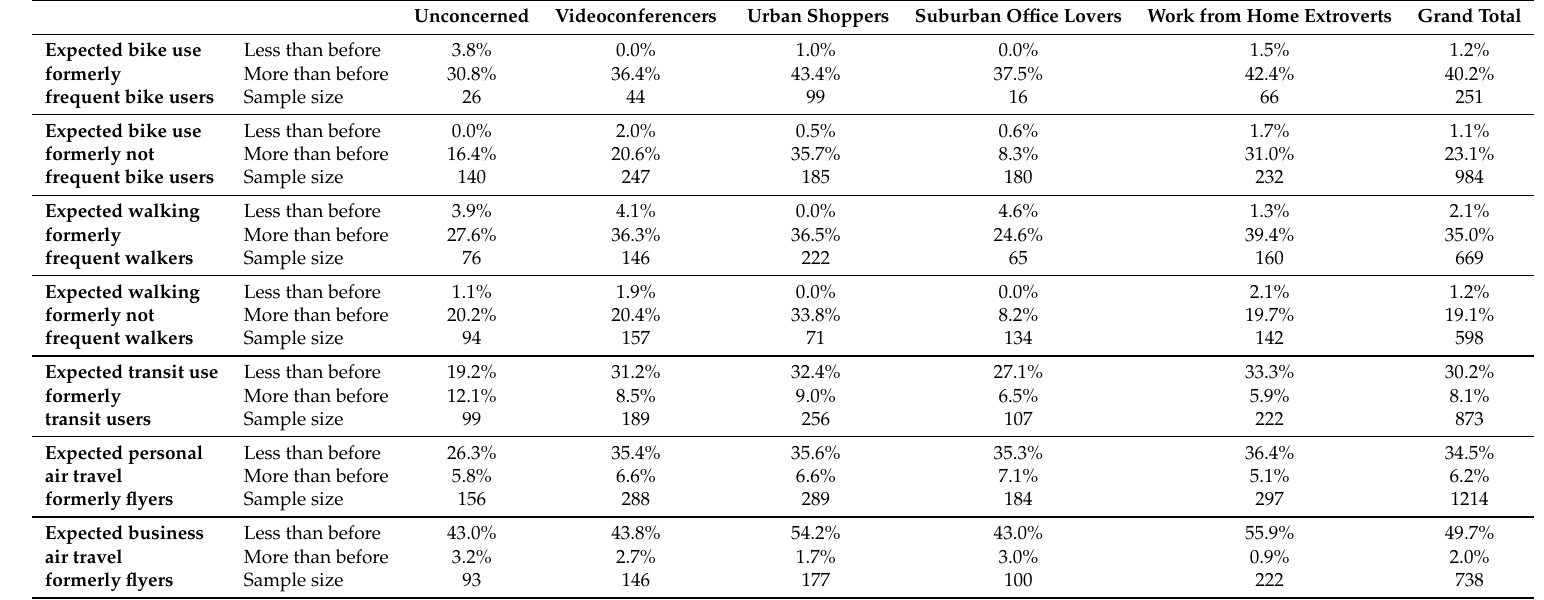
Table 7. Expected change in non-motorized mode use after the pandemic, by attitudinal typology and previous use of walking and biking. Unconcerned Videoconferencers Urban